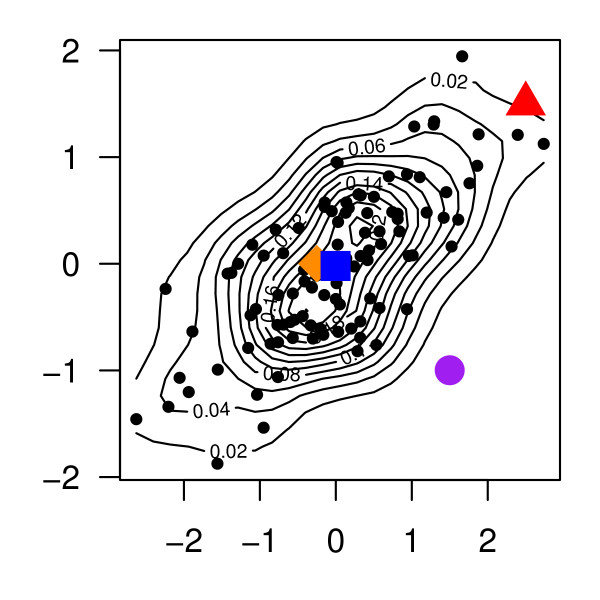
Mahalanobis distance plot example. A contour plot overlaying the scatterplot of 100 random draws from a bivariate normal distribution with mean zero, unit variance, and 50% correlation. The centroid defined by the marginal means is noted by a blue square. Three points of interest are added as the orange diamond, red triangle, and purple circle. If any of these points had been the observed value that gave rise to this null distribution its p-value would be 0.94, 0.04, < 0.01, respectively.